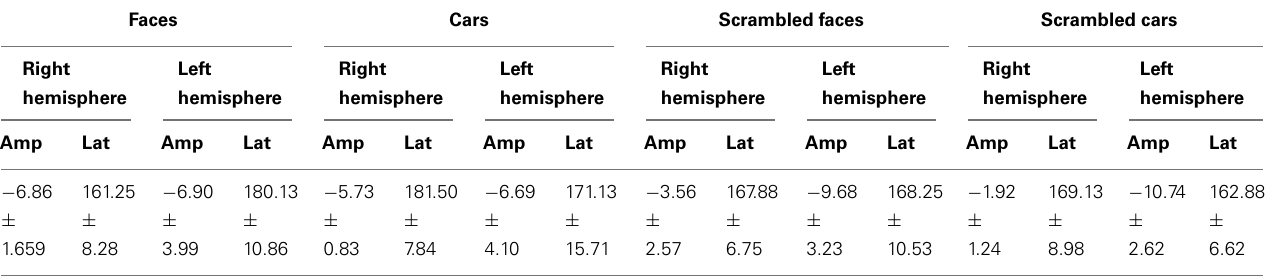
Table 4 | Mean amplitude and latency values of N170 component for PS. Faces Cars Scrambled faces Scrambled cars Right Left Right Left Right Left Right Left hemisphere hemisphere hemisphere hemisphere hemisphere hemisphere hemisphere